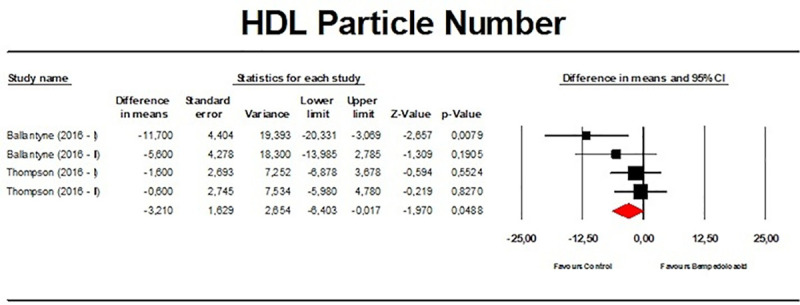
Forest plot displaying mean difference and 95% confidence intervals for the effect of bempedoic acid on plasma levels of high-density lipoprotein (HDL) particle number.